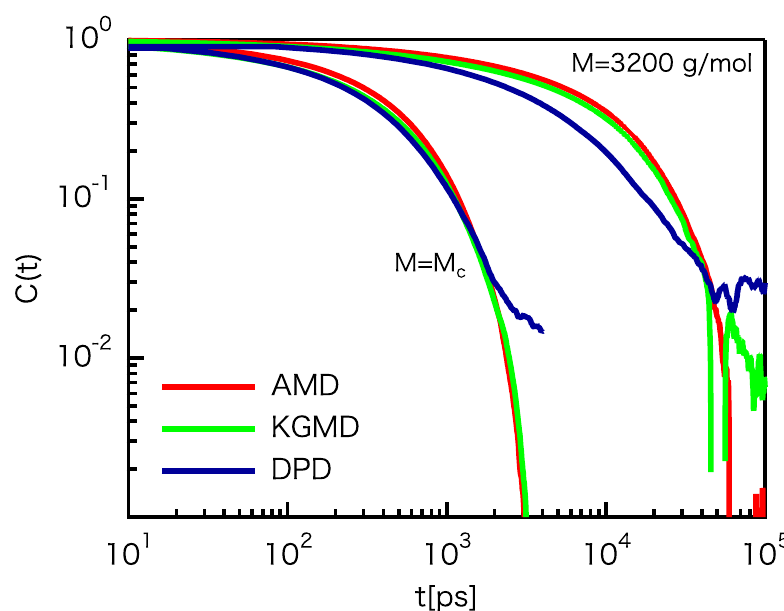
Figure 5. Comparison of the time-correlation functions of the end-to-end vector for the UA PE model and rescaled CG